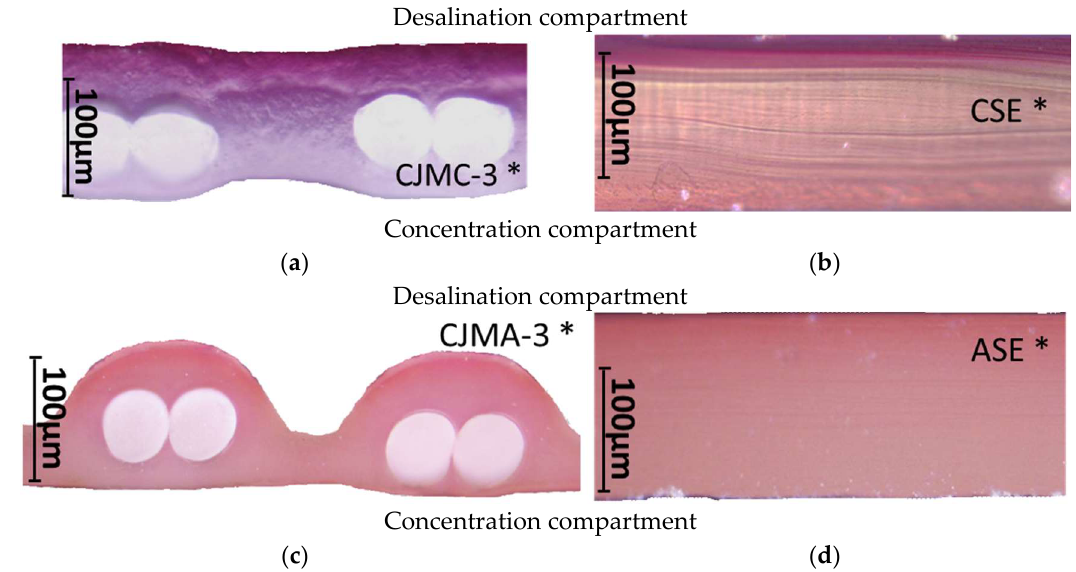
Figure 5. Optical images of cross sections of the studied cation-exchange ( a , b ) and anion-exchange ( c , d ) membranes after electrodialysis, indicating the location of the DC (desalination compartment) and CC 1 or CC 2 (concentration compartment) relative to the membrane cross sections.